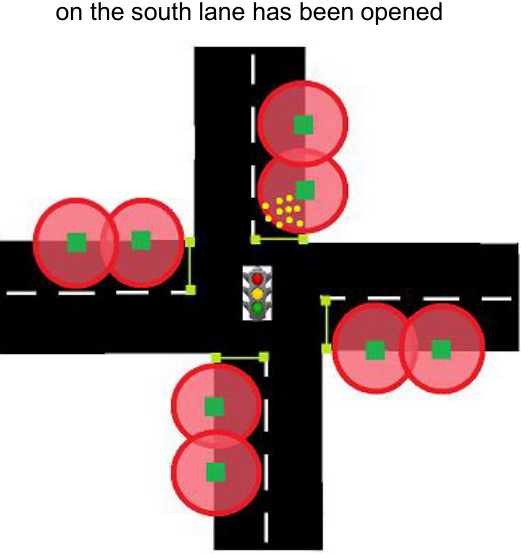
Figure 4. Iteration 2:post 30 seconds -signal on the north lane has been opened